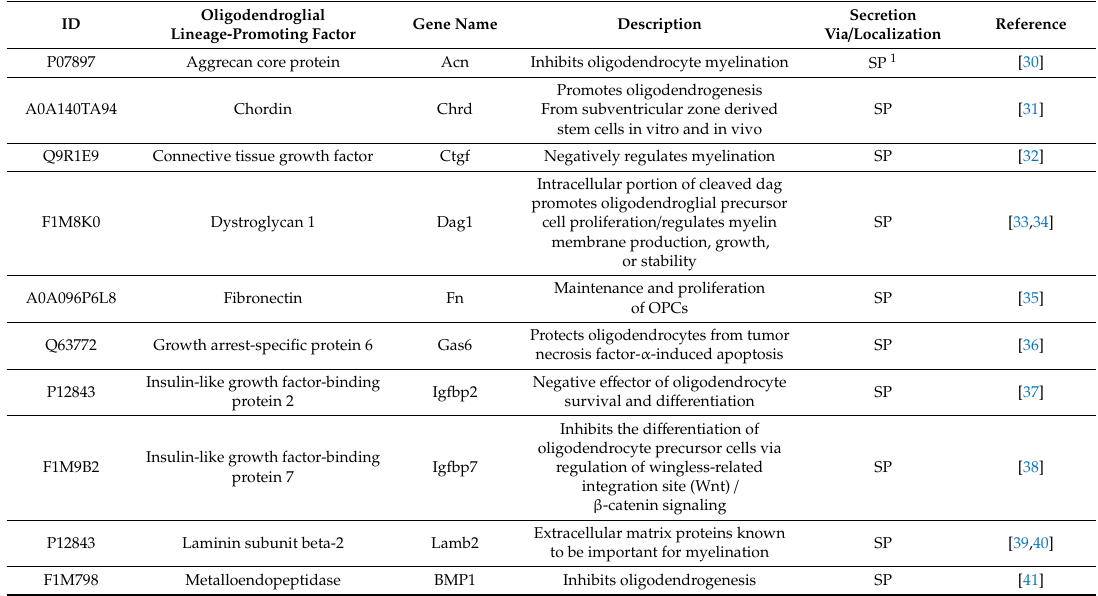
Table 1. Mesenchymal stem cell-secreted proteins associated with oligodendroglial lineage regulation.